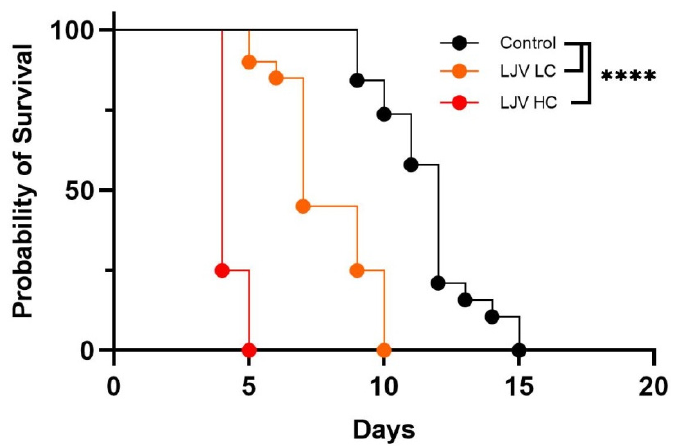
Figure 2. Survival of female Ds flies following the oral administration of LJV. Black line = untreated control, orange line = LJV low concentration (LC) of 10 5 GE/mL, and red line = LJV high concentration (HC) of 10 6 GE/mL. There was a significant difference in survival between LJV-fed flies and the untreated control (**** p < 0.0001).